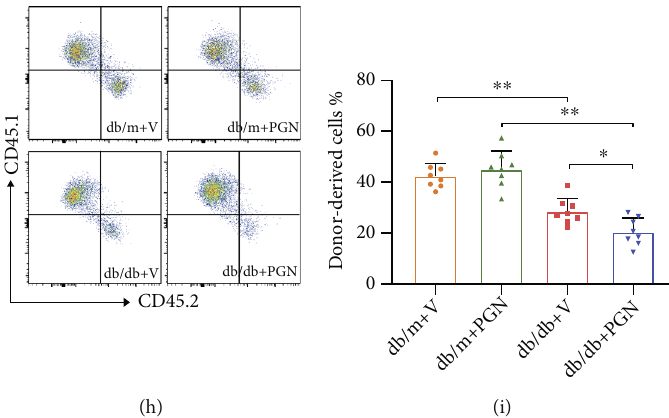
Figure 2: Peptidoglycan worsened diabetes-induced HSPC depletion and impairment in the bone marrow. (a) Representative fl ow cytometry gating scheme for the HSPC subpopulations in each group. (b – d) Flow cytometry analysis shows the percentage of (c) LT- HSC subpopulation was decreased in PGN-treated db/db mice group, while the percentages of (b) LSK and (c) ST-HSC were not a ff ected by PGN injections ( n = 11 − 13 per group). (e) Colony-forming capacity of bone marrow cells and blood cells from db/m and db/db mice treated with either PGN or vehicle control were tested in CFU assay. Colonies of BFU-E, CFU-G/M/GM, and CFU-GEMM using the bone marrow cells and total colony numbers using the peripheral blood were calculated after 10 days culture ( n = 8 − 10 per group). (f) LSK cells from each group were grown in LTC-IC cultures for 4 weeks, followed by methylcellulose plating and culture for